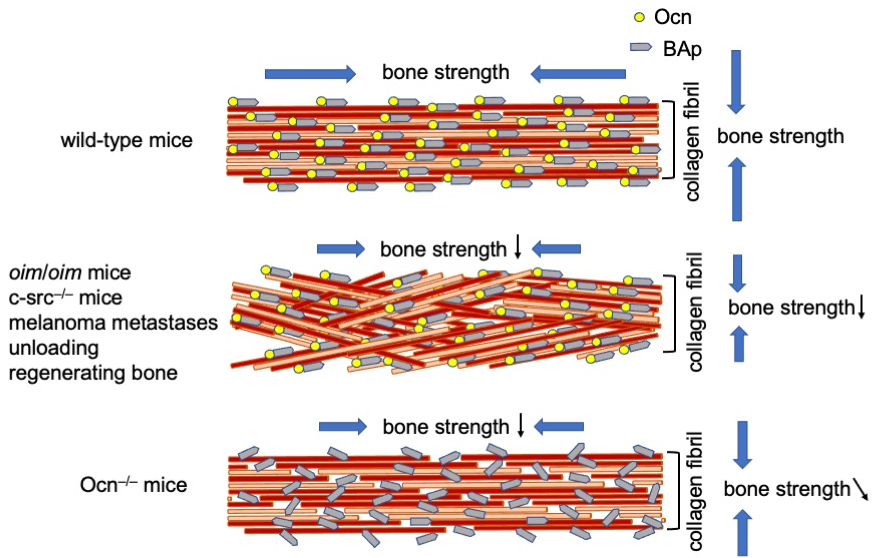
Figure 1. Alignment of collagen fibers and BAp. In wild-type mice, the orientation of collagen fibers is parallel to the longitudinal direction of long bone at the diaphysis, and that of BAp is parallel to the collagen fibers. In the mouse models and bone types, including oim / oim osteogenesis imperfecta, c-src − / − osteopetrosis, melanoma metastases, unloading, and regenerating long bones, the alignment of collagen fibers is disrupted, but that of BAp is still parallel to the orientation of collagen fibers. The bone strength is reduced in both longitudinal and vertical directions of the long bone. In Ocn − / − mice, the orientation of collagen fibers is parallel to the longitudinal direction of the long bone, but the alignment of BAp is disrupted. The bone strength is reduced in the longitudinal direction of the long bone, and that in the tangential direction is slightly reduced. ↓ : reduced, (cid:38) : slightly reduced.